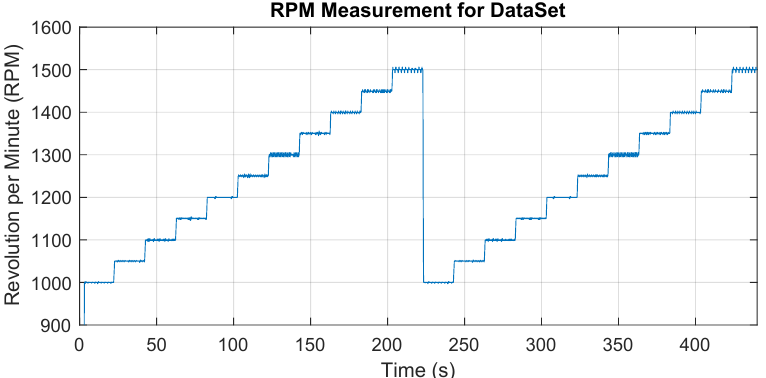
Figure 5. The variation of the spindle speed over time during the dataset